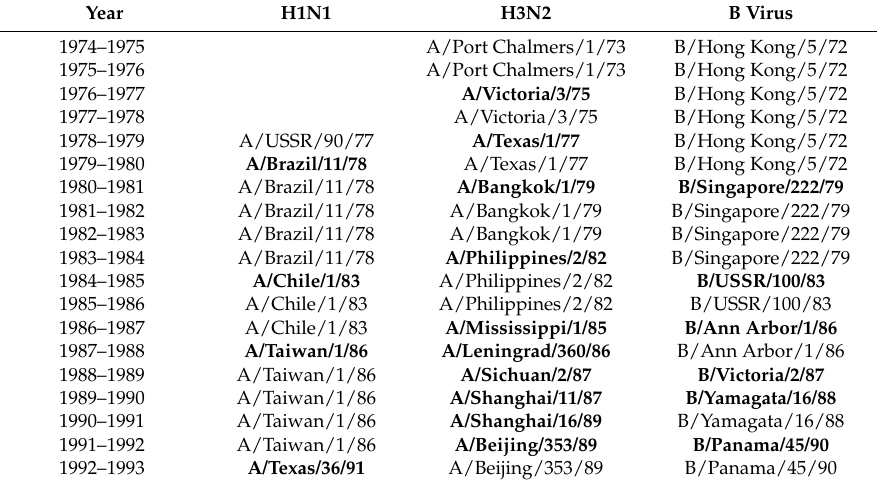
Table 5. Influenza Vaccine Strain Recommendations from the WHO and Influenza Research Database websites [42,43]. Changes from the previous recommendation are shown in bold.